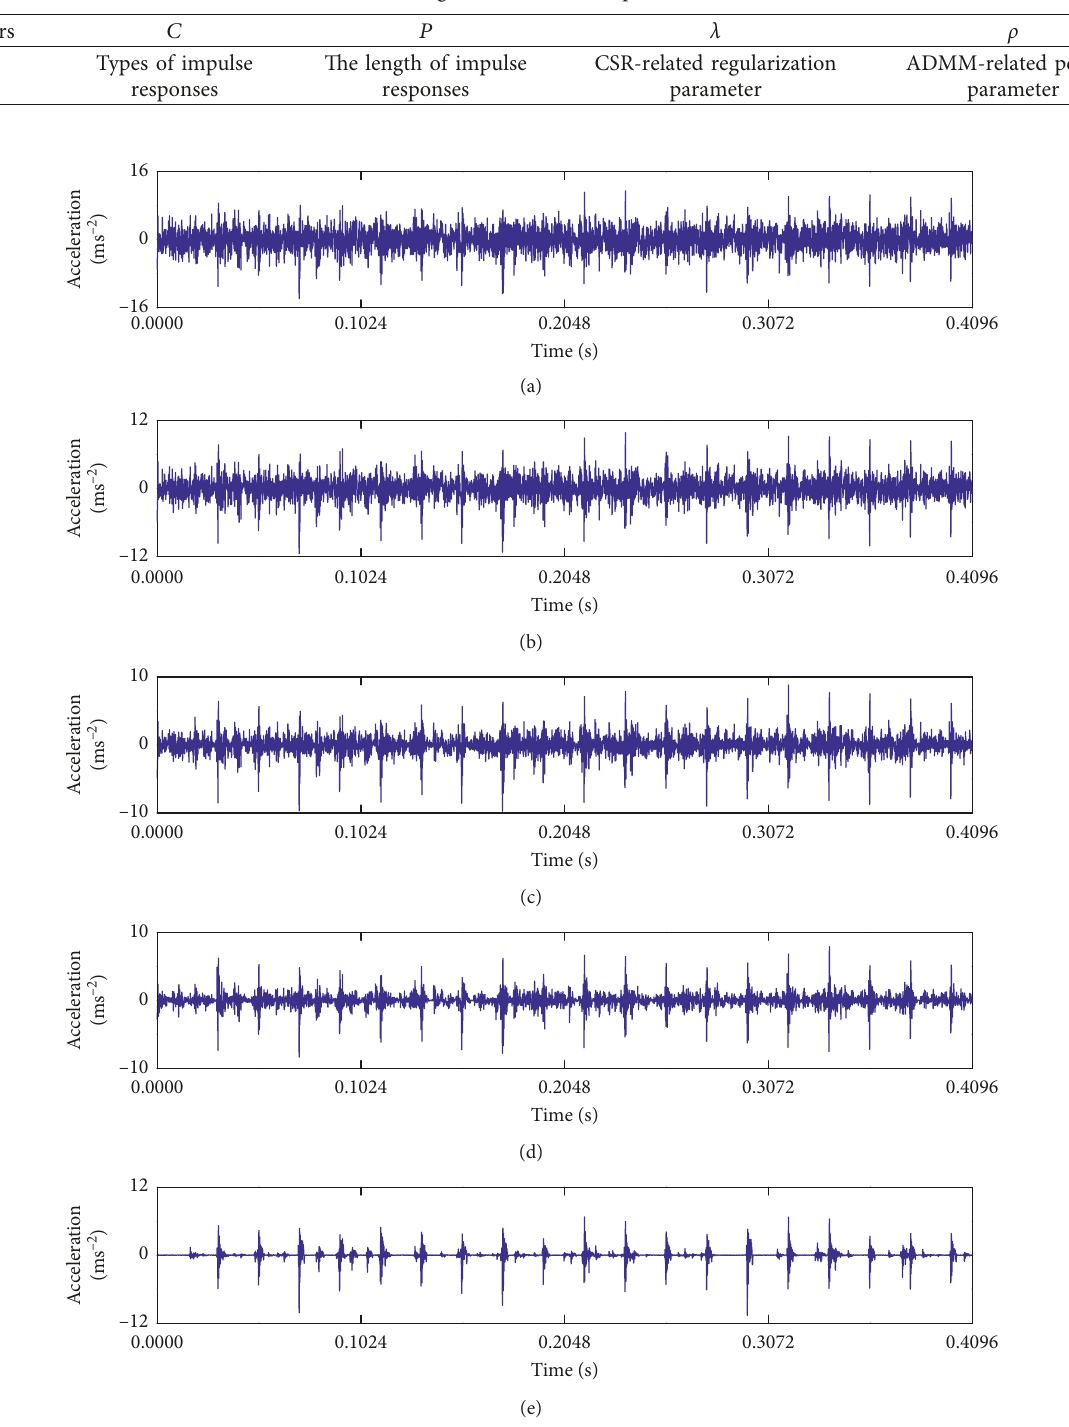
Figure 2: IRSs extracted using CSR for different parameters λ . (a) Original sound, kurtosis value � 40.3023. (b) λ � 1, kurtosis val- ue � 69.9564. (c) λ � 2, kurtosis value � 98.9707. (d) λ � 3, kurtosis value � 135.1575. (e) λ � 5, kurtosis value �